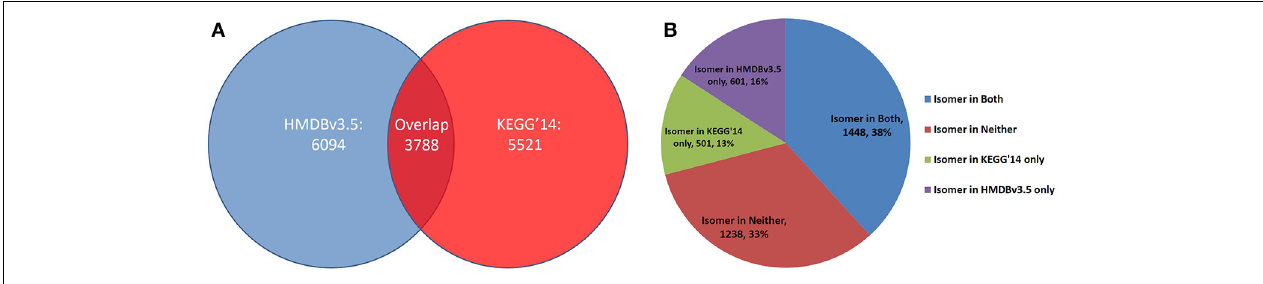
FIGURE 11 | Distinct molecular Formulae distributions across HMDBv3.5 and KEGG Ligand. (A) In each database, the number of distinct formulae was determined. Each formula was tested to see if it existed in the other database. Of a total 15,403 formulae, only 3788